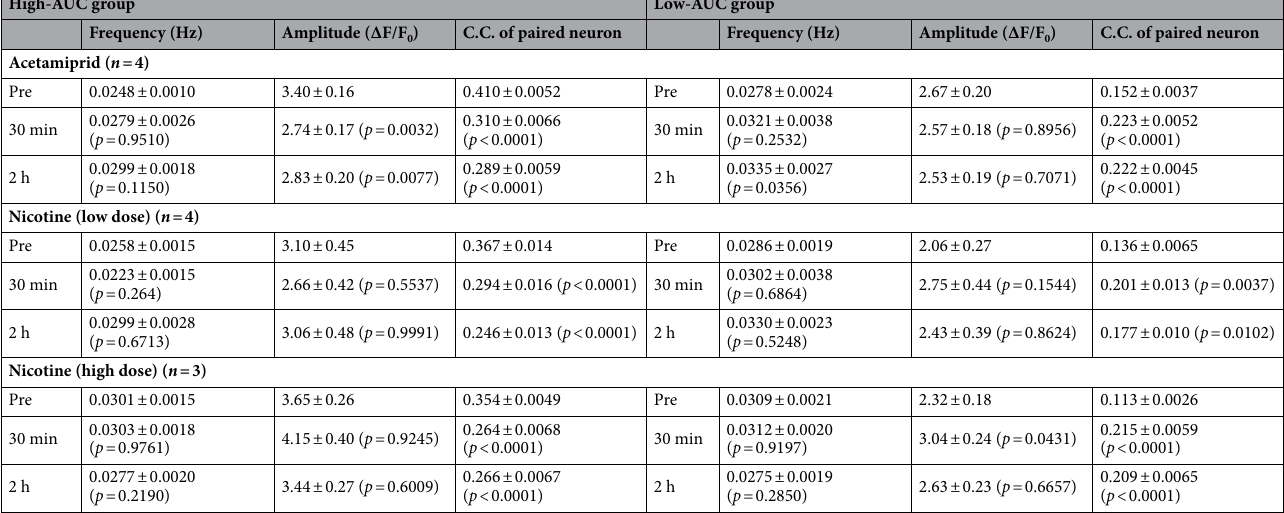
Table 3. Summary of the neuronal activities in the somatosensory cortex before, 30 min, and 2 h after administration. Abbreviations: AUC area under the curve, C.C. cross-correlation, min minutes, h hour.